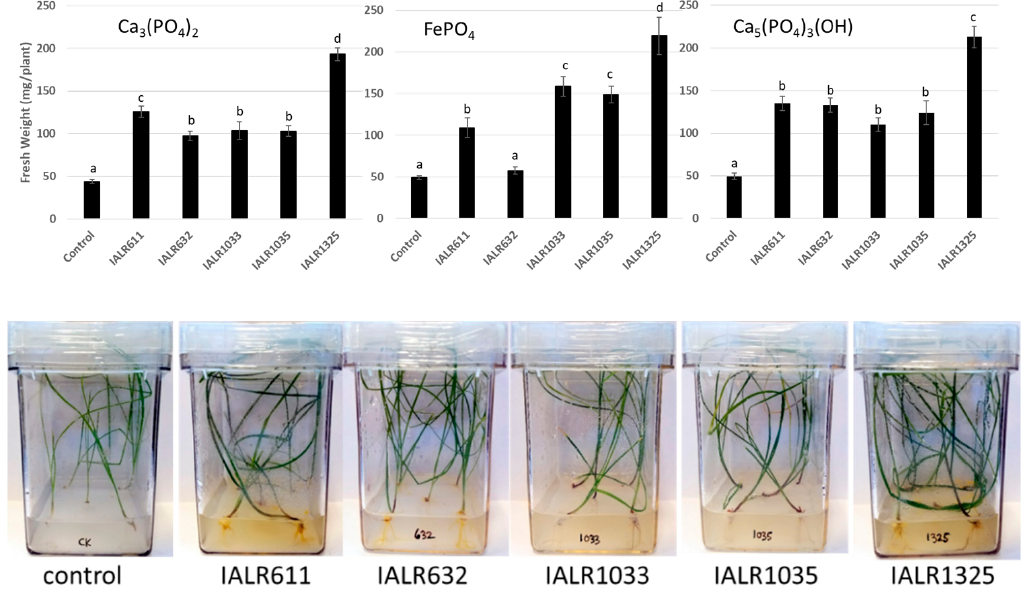
Figure 3. Top: tall fescue plant growth promotion by phosphate solubilizing bacteria in vitro with different insoluble phosphate compounds. Bottom: comparison of bacterium inoculated plants with control plants using Ca 3 (PO 4 ) 2 as the P source in the medium. Different letters on bars mean significantly different at p < 0.05.